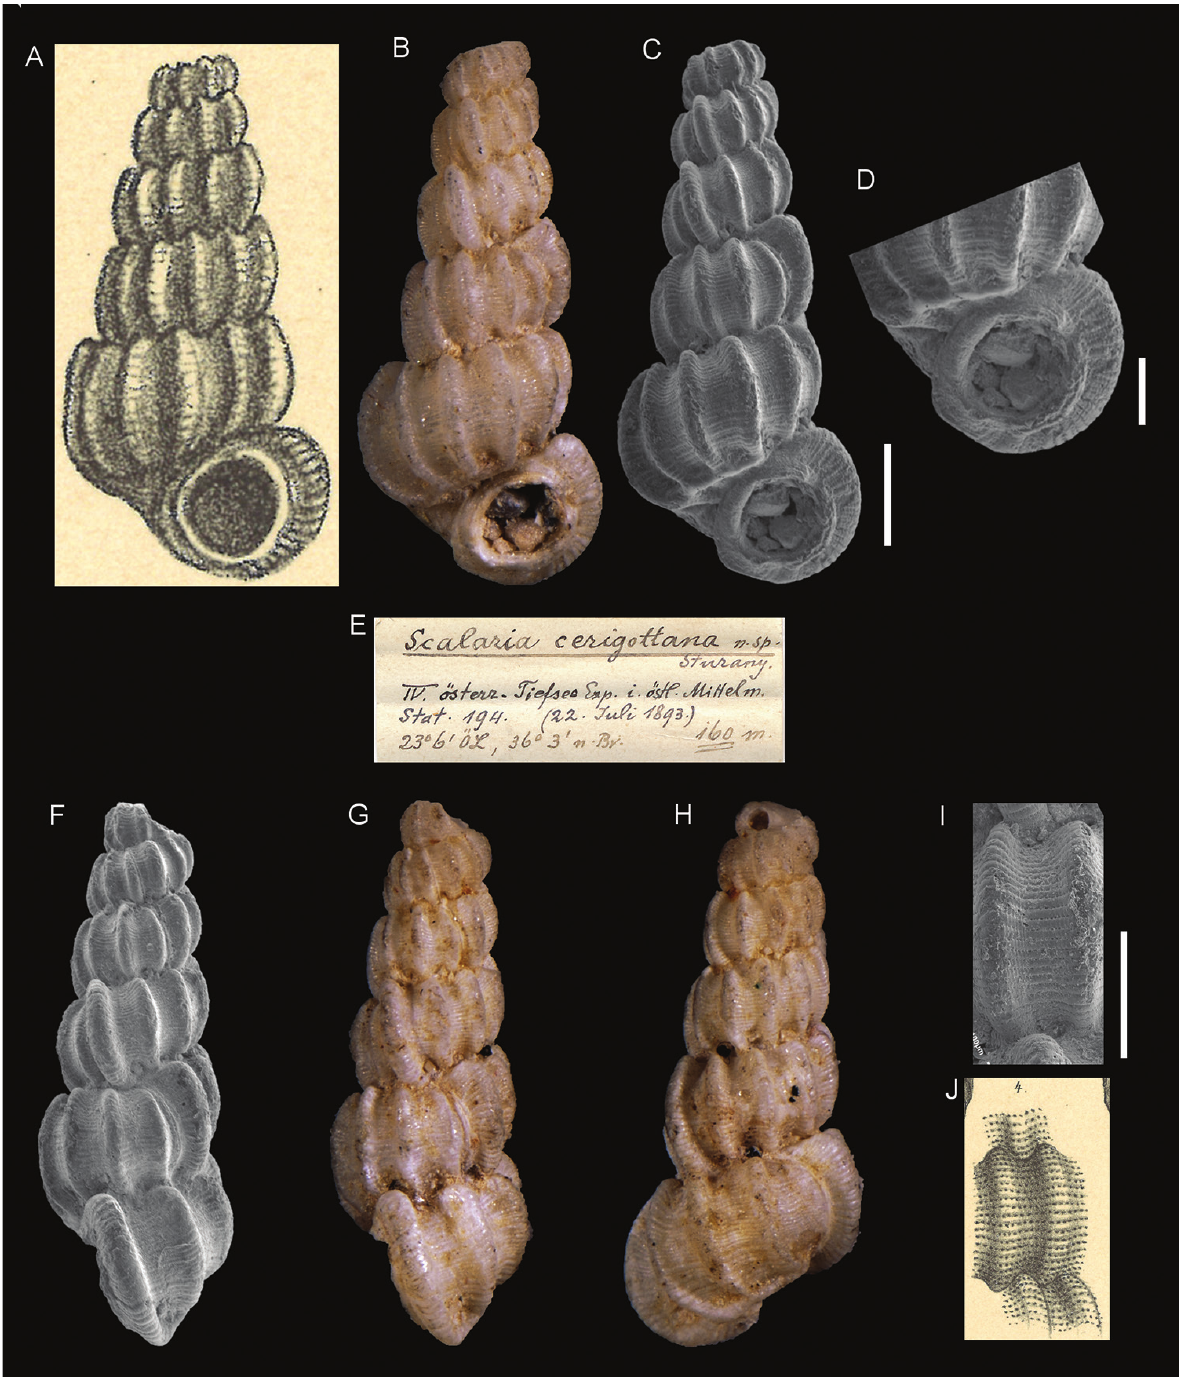
Figure 3. Scalaria cerigottana Sturany, 1896, Station 194, between Kythira and Antikythera, Ionian Sea, Greece, 160 m. A , J . Original figures in Sturany, 1896. B–D, F–I . Holotype NHMW 13001: front ( B–C ), side ( F–G ), and back ( H ) views, aperture ( D ), microsculp- ture ( I ). E. Original label. Scale bar: 1 mm ( B–C , F–H ); 0.5 mm ( D , I